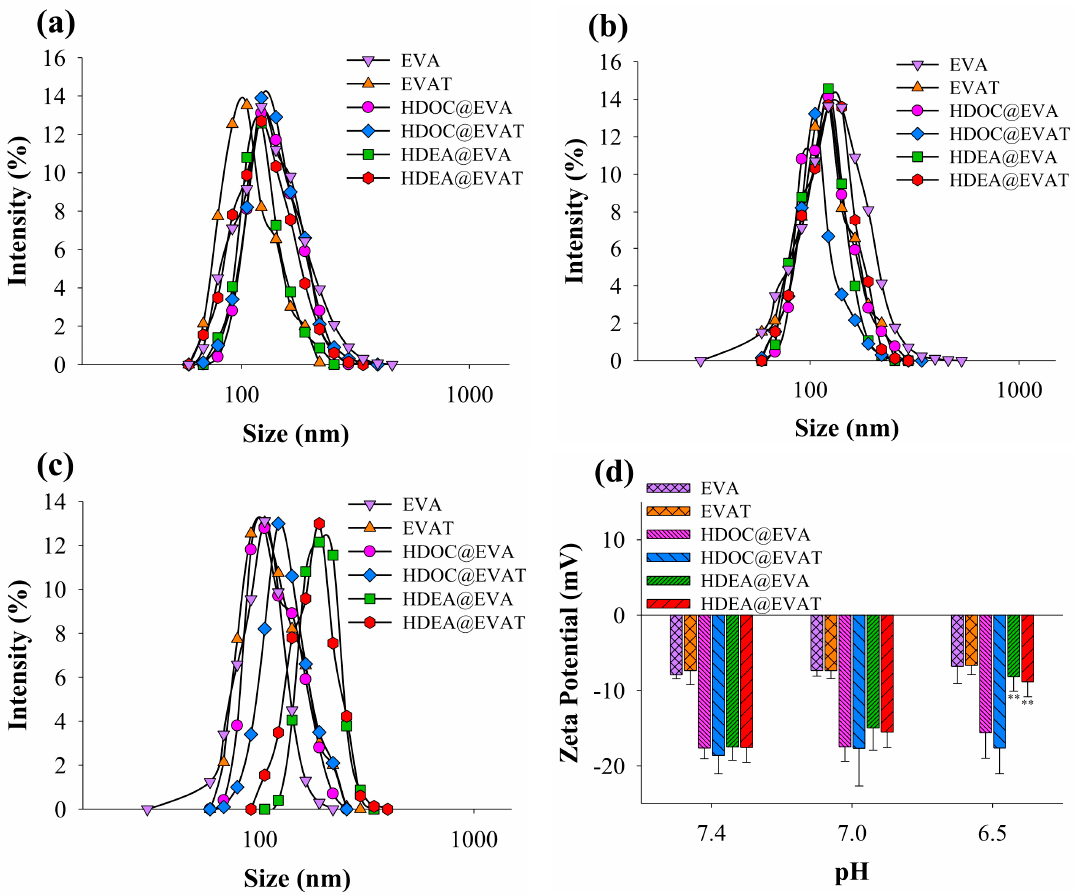
Figure 2. Particle size distributions of extracellular vesicles (EVs) at pH values of ( a ) 7.4; ( b ) 7.0; and ( c ) 6.5; ( d ) Zeta potential changes of EVs at pH values of 7.4, 7.0, or 6.5 ( n = 3) (** p < 0.01 compared to pH of 7.4).